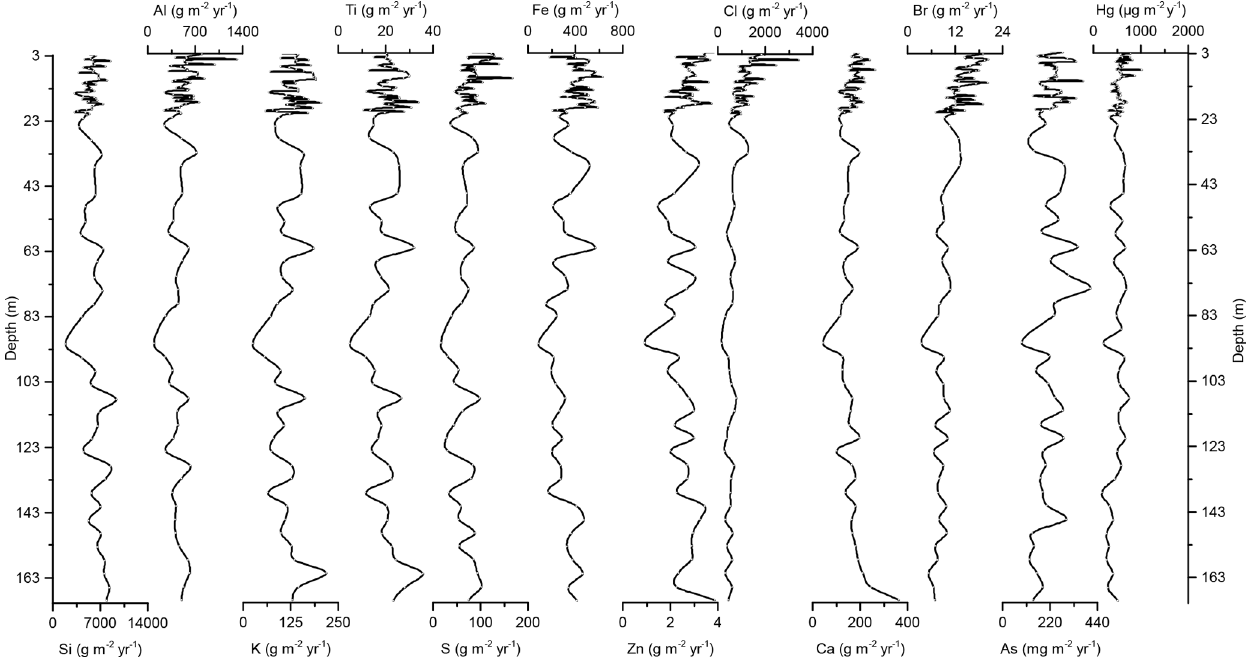
Figure 4. Down-core records of Si, Al, K, Ti, S, Fe, Zn, Cl, Ca, Br, As, and Hg accumulation rates of Adélie Basin sediments.